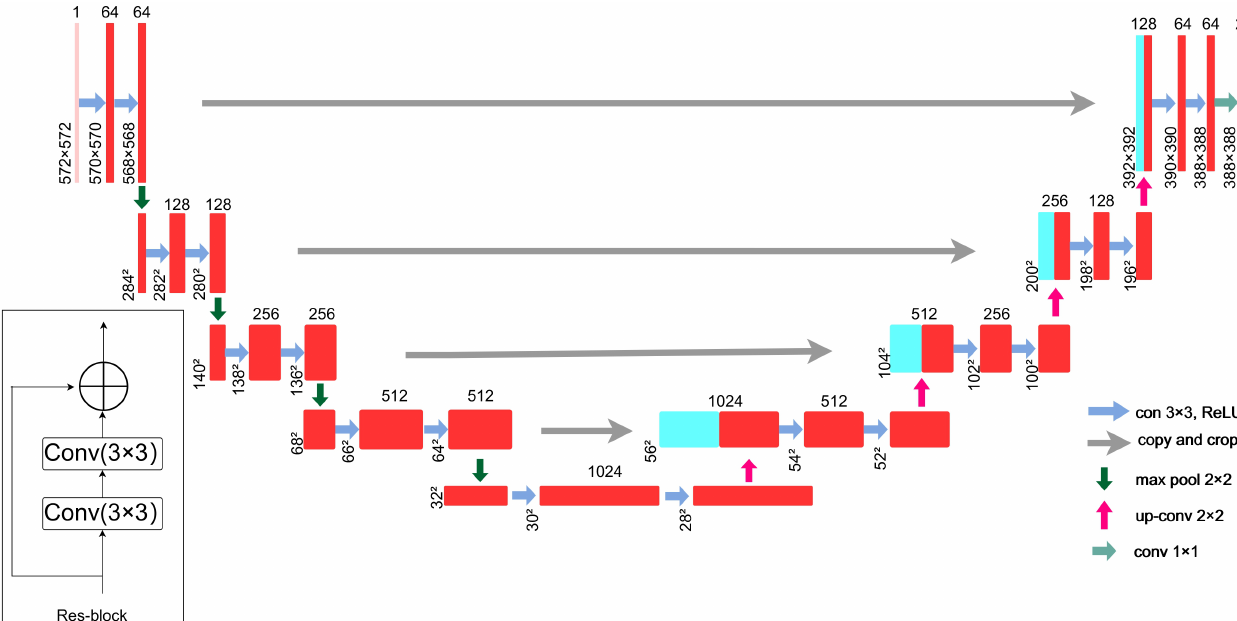
Figure 8. A deep learning framework combining U-net and